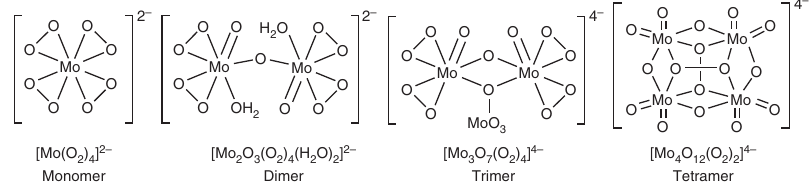
Figure 1 | Examples of peroxomolybdate complexes. Monomeric, dimeric, trimeric and tetrameric peroxomolybdates generated by treating molybdate with H 2 O 2 .